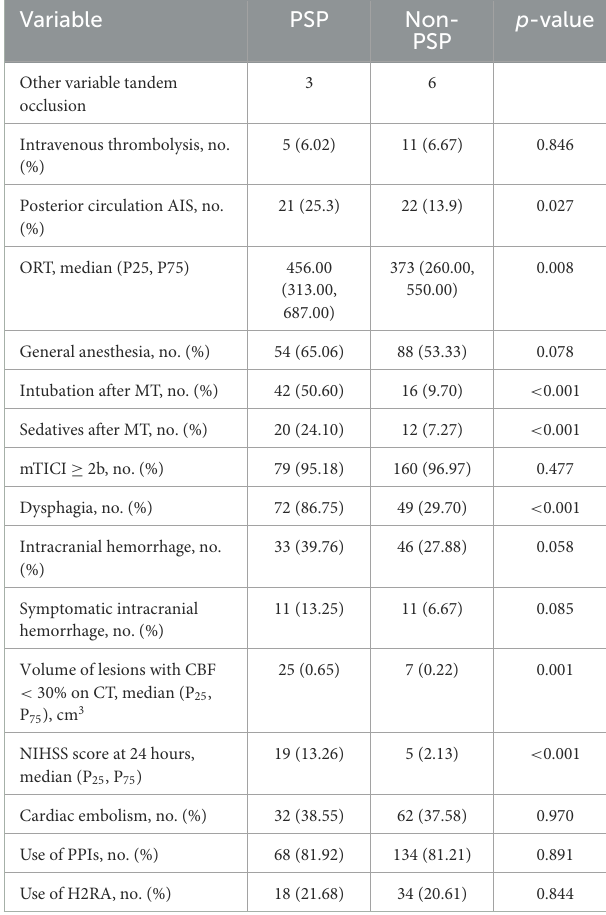
TABLE 1 Univariate analysis of predictive factors for developing poststroke pneumonia after mechanical